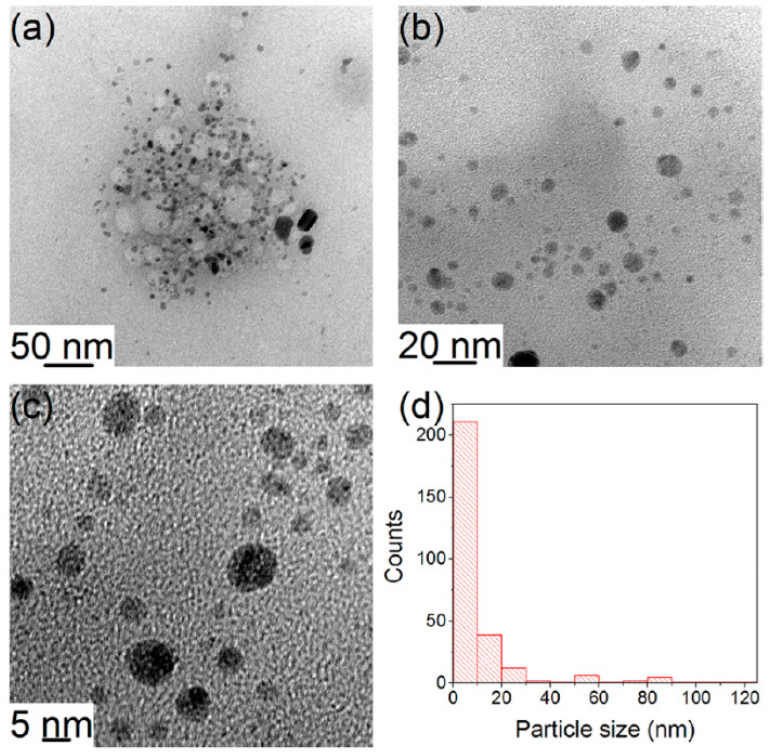
Figure 9. ( a – c ) TEM images of the LiBH 4 nanoparticles and ( d ) corresponding size distribution. Reprinted with permission from [105]. Copyright (2018), American Chemical Society.